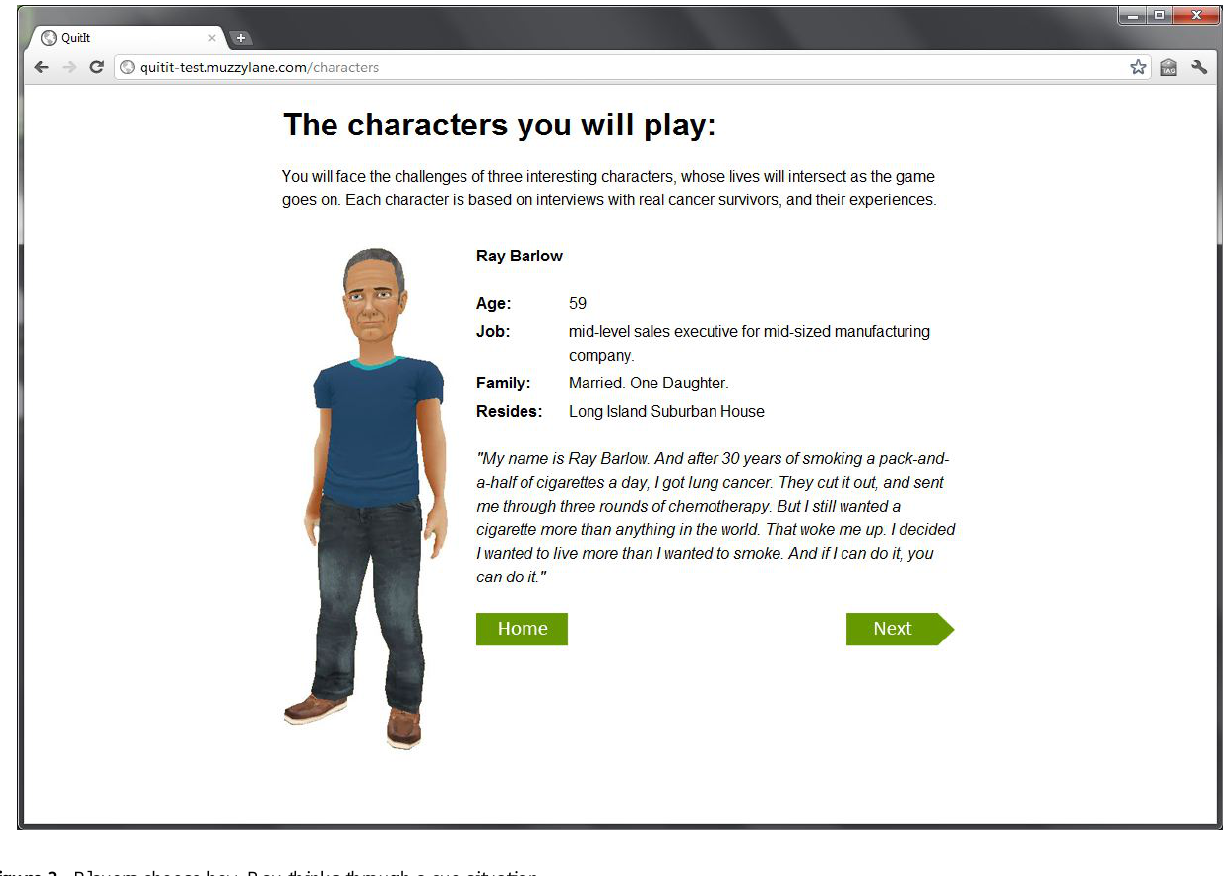
Figure 2. Introduction to Ray, the main character.